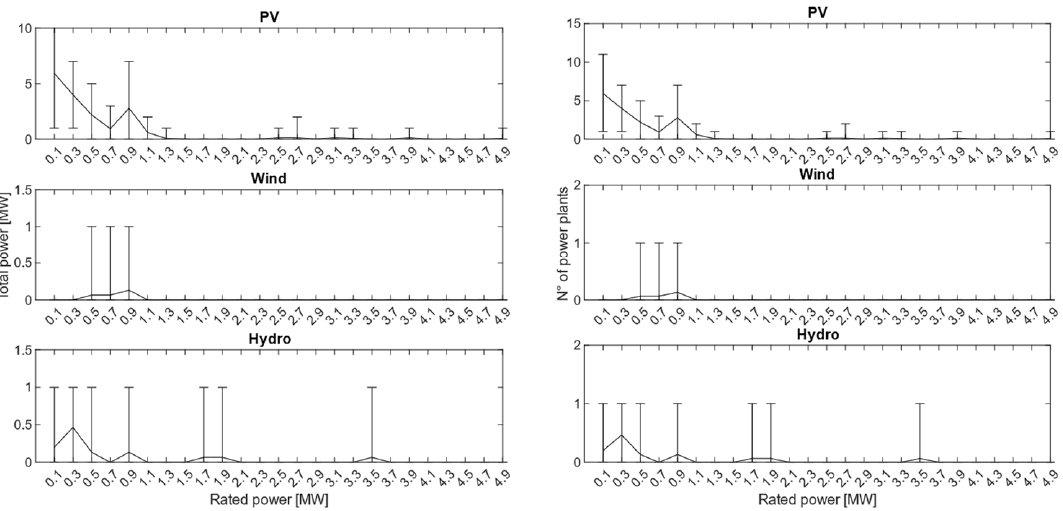
Figure 5. Distribution of NDRES power plants in the EVU: overall generation ( left ) and number of NDRES units ( right ) per category of plant’s rated size (200 kW).